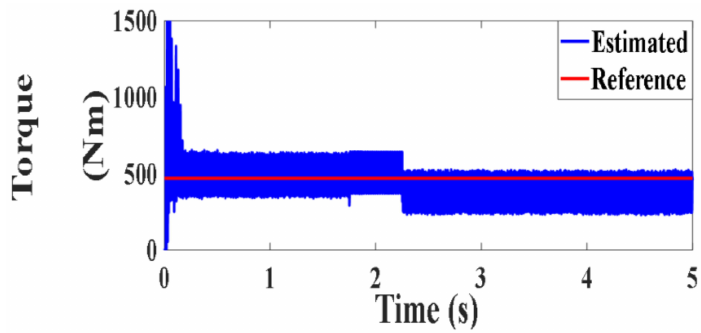
Figure 26. Developed torque under MPCC (Nm).